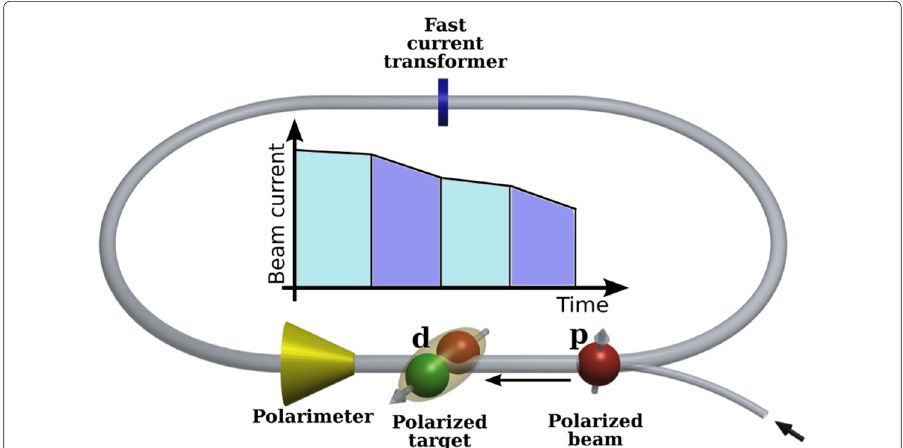
Fig. 4 Main components of the experimental setup for the TIVOLI experiment: polarized beam from the injector cyclotron, polarized deuteron target from an ABS, polarimeter and beam current sensor. Time reversal invariance will be accessed by detecting the difference in the beam lifetime between the situation a) and c) or d), depicted in Fig. 3, as schematically indicated in the